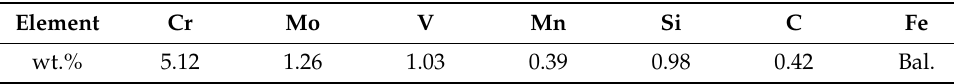
Table 1. Chemical Compositions of the H13 powders (wt.%). Element